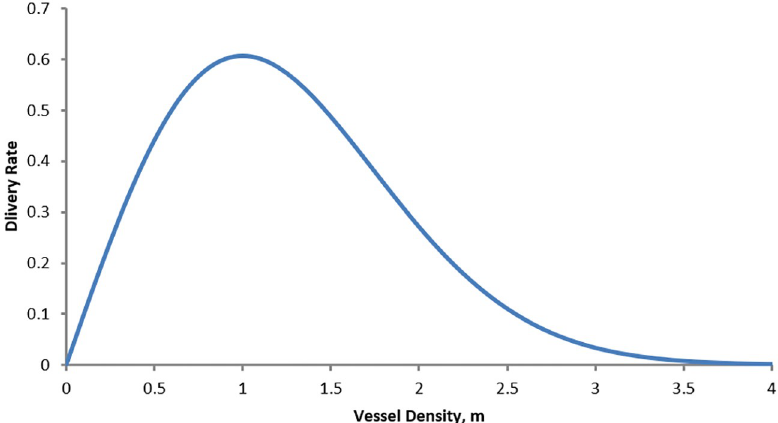
Fig 2. Delivery rate from vessels as a function of the average vessel density. Curve is described by the function me (cid:0) ð m mlim Þ 2 . Notice that the optimal vessel delivery occurs at m = 1. As m becomes greater than 1, the delivery rate decreases, allowing for the impaired delivery due to